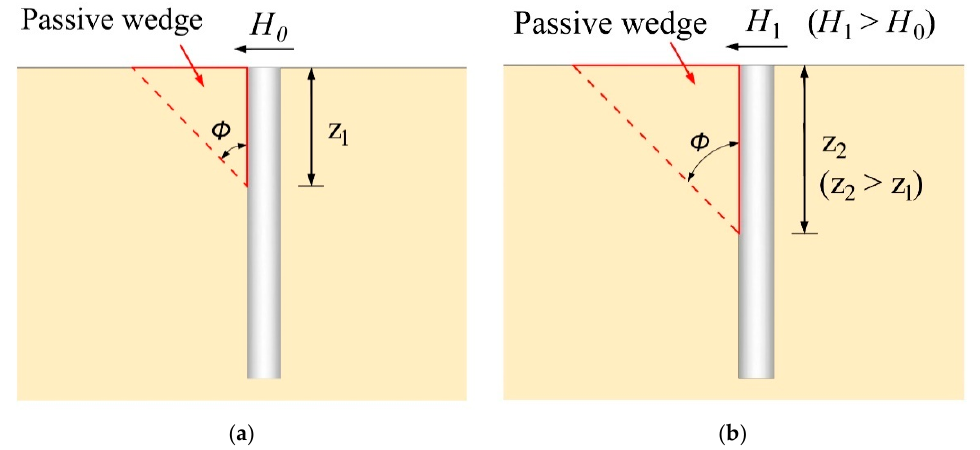
Figure 10. The wedge failure model at shallow depth for level ground. ( a ) H 0 and ( b ) H 1 . Yang et al. analyzed the near-slope failure wedge for three “existence of the slope geometry effect” cases. The study considered that as the load increased, the passive wedge expanded, and the passive wedge shape changed from a triangle to a concave quadrilateral [31]. However, a theoretical largest passive wedge exists because the depth of the bottom of the wedge will not exceed the first bending point of the pile. Similarly, for the changing ℎ (cid:2926) case in this paper, the shape of the largest passive failure wedge changes from a concave quadrilateral for a small ℎ (cid:2926) value to a triangle for a larger ℎ (cid:2926) value, as shown in Figure 11, where 𝑧 (cid:2930) is the depth of the first turning point, and 𝑧 (cid:2913)(cid:2928) is the depth of the intersection of the bottom plane of the largest passive wedge and the slope surface. ( a ) ( b ) Figure 11. The theoretical largest passive wedge for ( a ) ℎ (cid:3043)(cid:2869) and ( b ) ℎ (cid:3043)(cid:2870) . For “existence of the slope geometry effect” cases, when the slope angle remains con- stant, the shape of the theoretical largest passive wedge changes with ℎ (cid:2926) when ℎ (cid:2926) < 𝑧 (cid:2913)(cid:2928) /𝐿 , but remains constant when ℎ (cid:2926) ≥ 𝑧 (cid:2913)(cid:2928) /𝐿 , as shown in Figure 11. This indicates that “existence of the slope geometry effect” cases are the same as “no slope geometry effect” cases when ℎ (cid:2926) ≥ 𝑧 (cid:2913)(cid:2928) /𝐿 . The reduction factor ( 𝜇 (cid:2918) (cid:3174) ) can be calculated for the dimensionless slope height ( ℎ (cid:2926) ) variation case as follows: